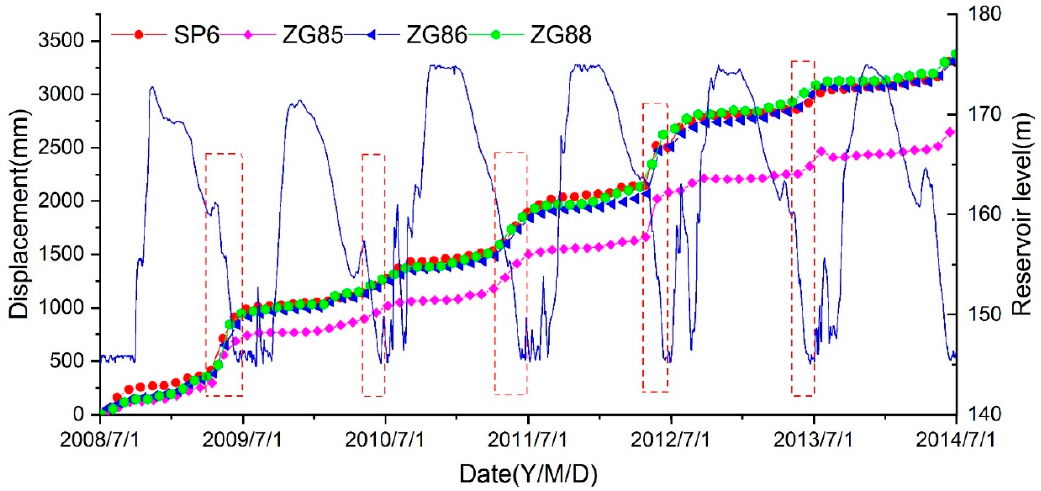
Figure 3. Monitoring data of the accumulative displacement and the reservoir water level of the Shuping landslide from July 2008 to July 2014. The red rectangular boxes represent the periods with faster movement.